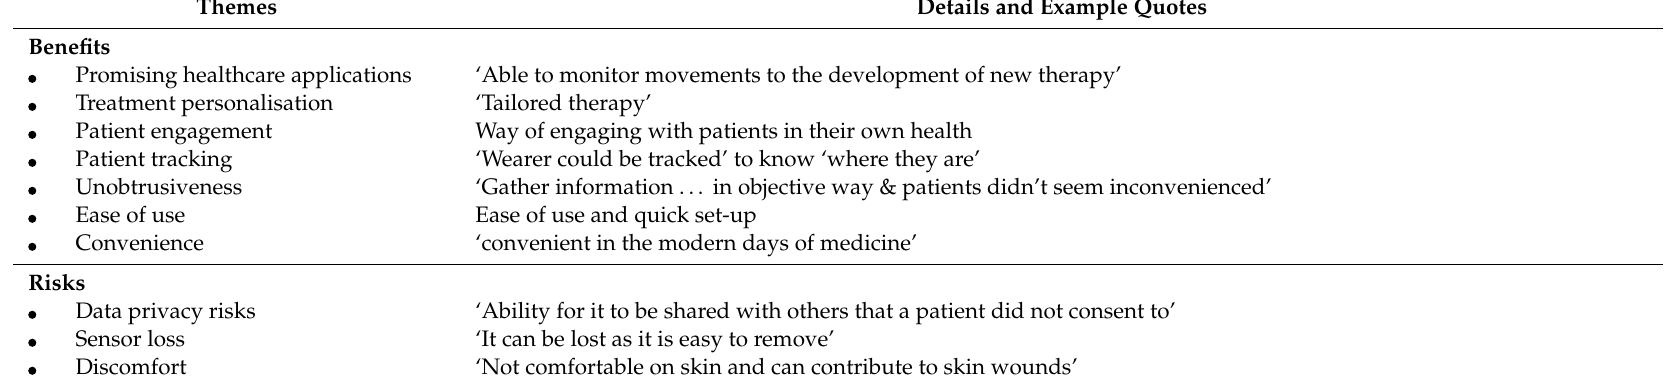
Table 4. Themes of perceived benefits, risks, likes, dislikes, expected functions and characteristic of technology from the healthcare professional survey (hoQ1–4).